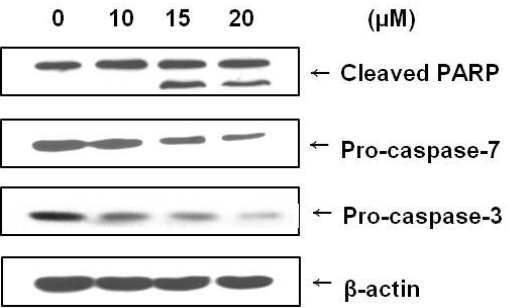
Figure 4. Immunoblot demonstrating the effect of brazilin treatment on poly(ADP-ribose) polymerase (PARP) and caspases (3 and 7) in human U87 glioblastoma cells. Cells were incubated with different concentrations of brazilin for 24 h, lysed, and cellular proteins were separated by 12% SDS-polyacrylamide gels and transferred onto PVDF membranes. The membranes were probed with antiPARP, anticaspase-3, and anticaspase-7 antibodies. Proteins were visualized by the ECL detection system. Actin was used as an internal